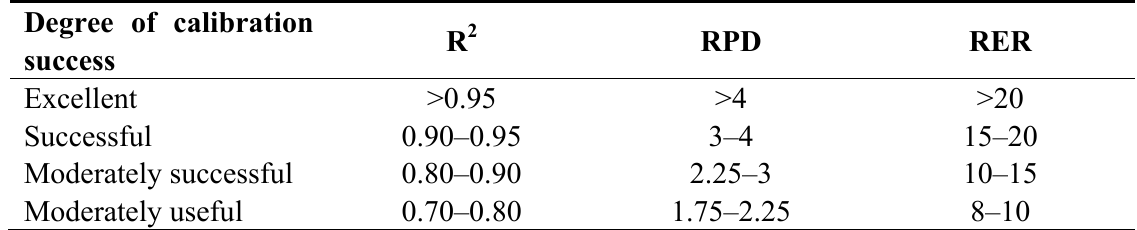
Table 2. Calibration performance criteria according to Malley